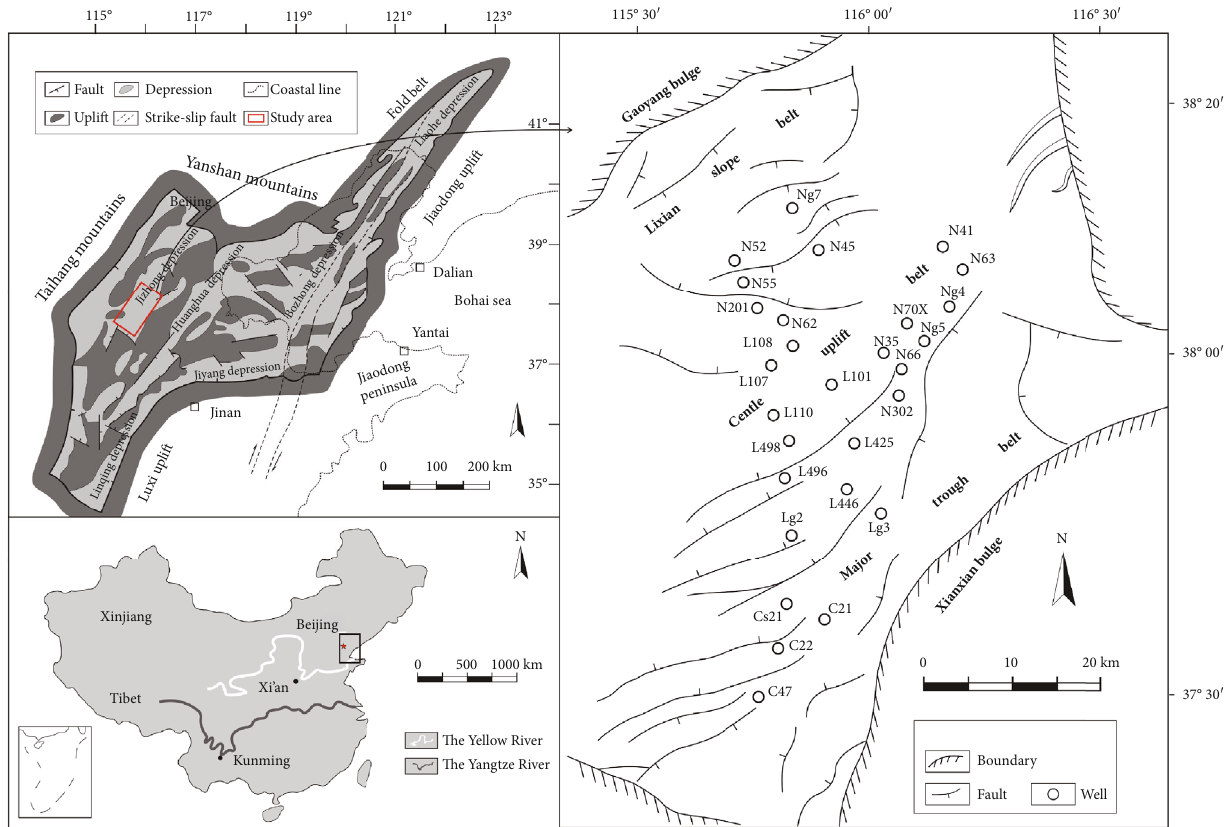
Figure 1: Tectonic setting of the Bohai Bay Basin, eastern China, and location map of the Raoyang Sag with its main structural features (modi fi ed from